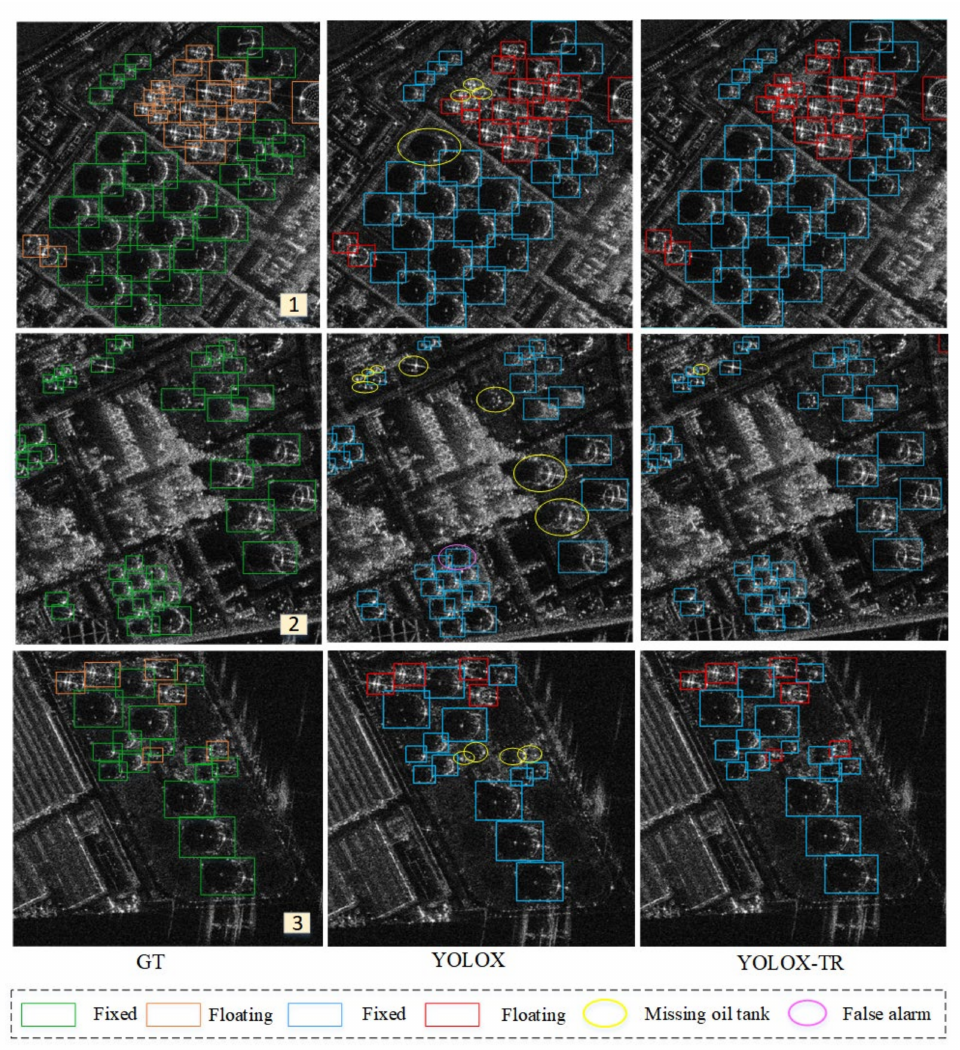
Figure 9. The visual detection results of the ablation experiments of the three densely arranged areas numbered 1–3 from Figure 8. The first column shows the ground truth (GT); the second column shows the detection results of the baseline YOLOX; and the third column shows the detection results of